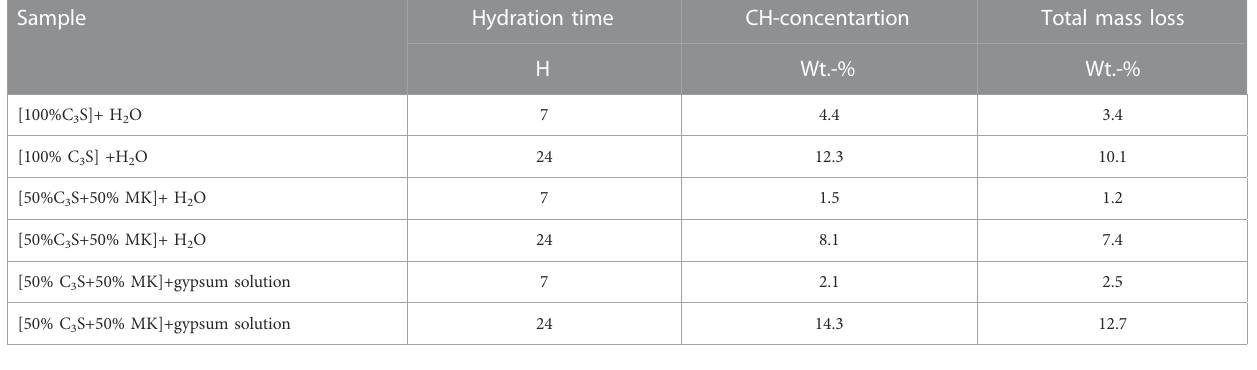
TABLE 2 Portlandite (CH) concentration and total mass loss of C 3 S-pastes hydrated for 7 and 24 h. Sample